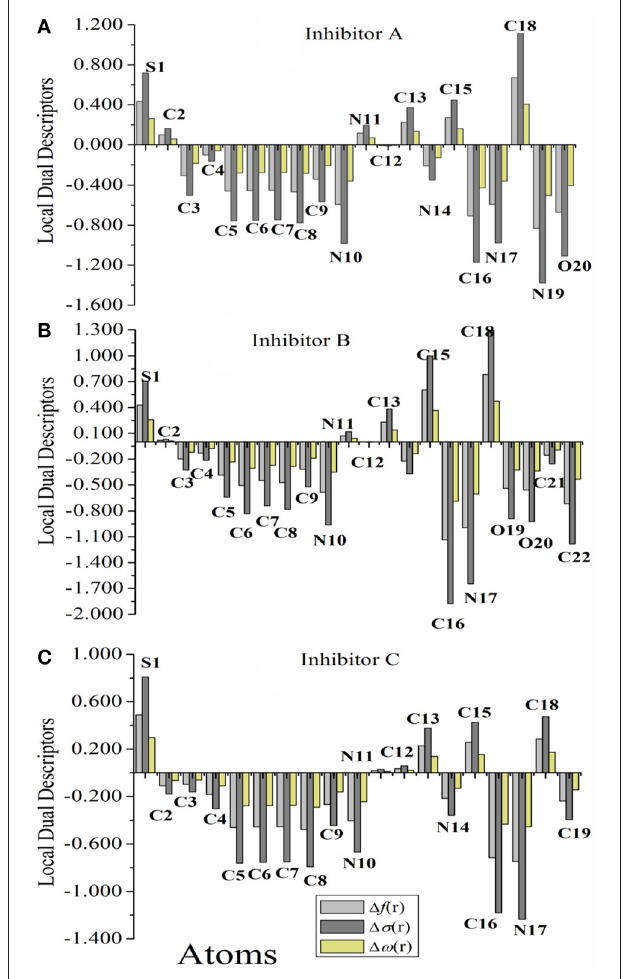
FIGURE 3 | (A–C) Graphical representation of the local dual descriptors, 1 f , 1σ , and 1ω , based on Fukui Functions of the studied inhibitors A, B, and C (the atom-numbering is in correspond with Figure 1